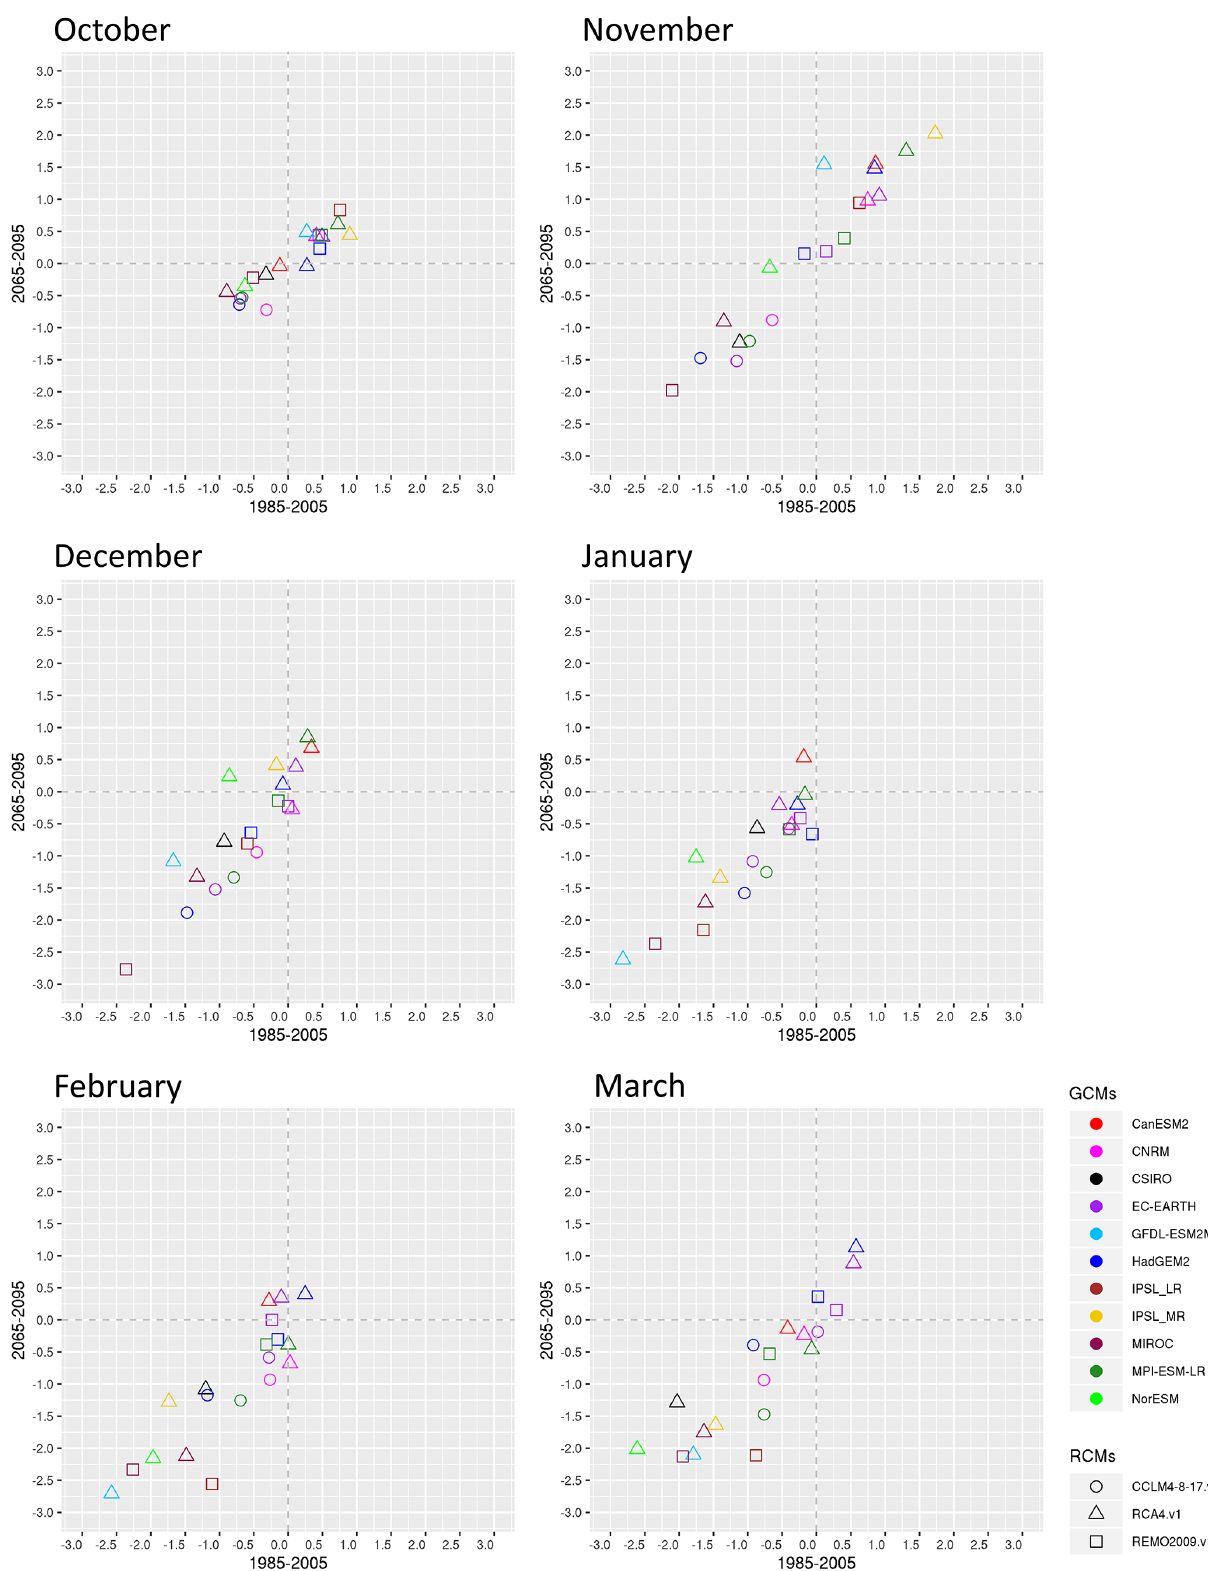
Figure 12. Monthly RCM DRI –DRI spatial averages over southern Africa for the historical period (1985–2005) on the x axis and the future period (2065–2095) under RCP8.5 on the y